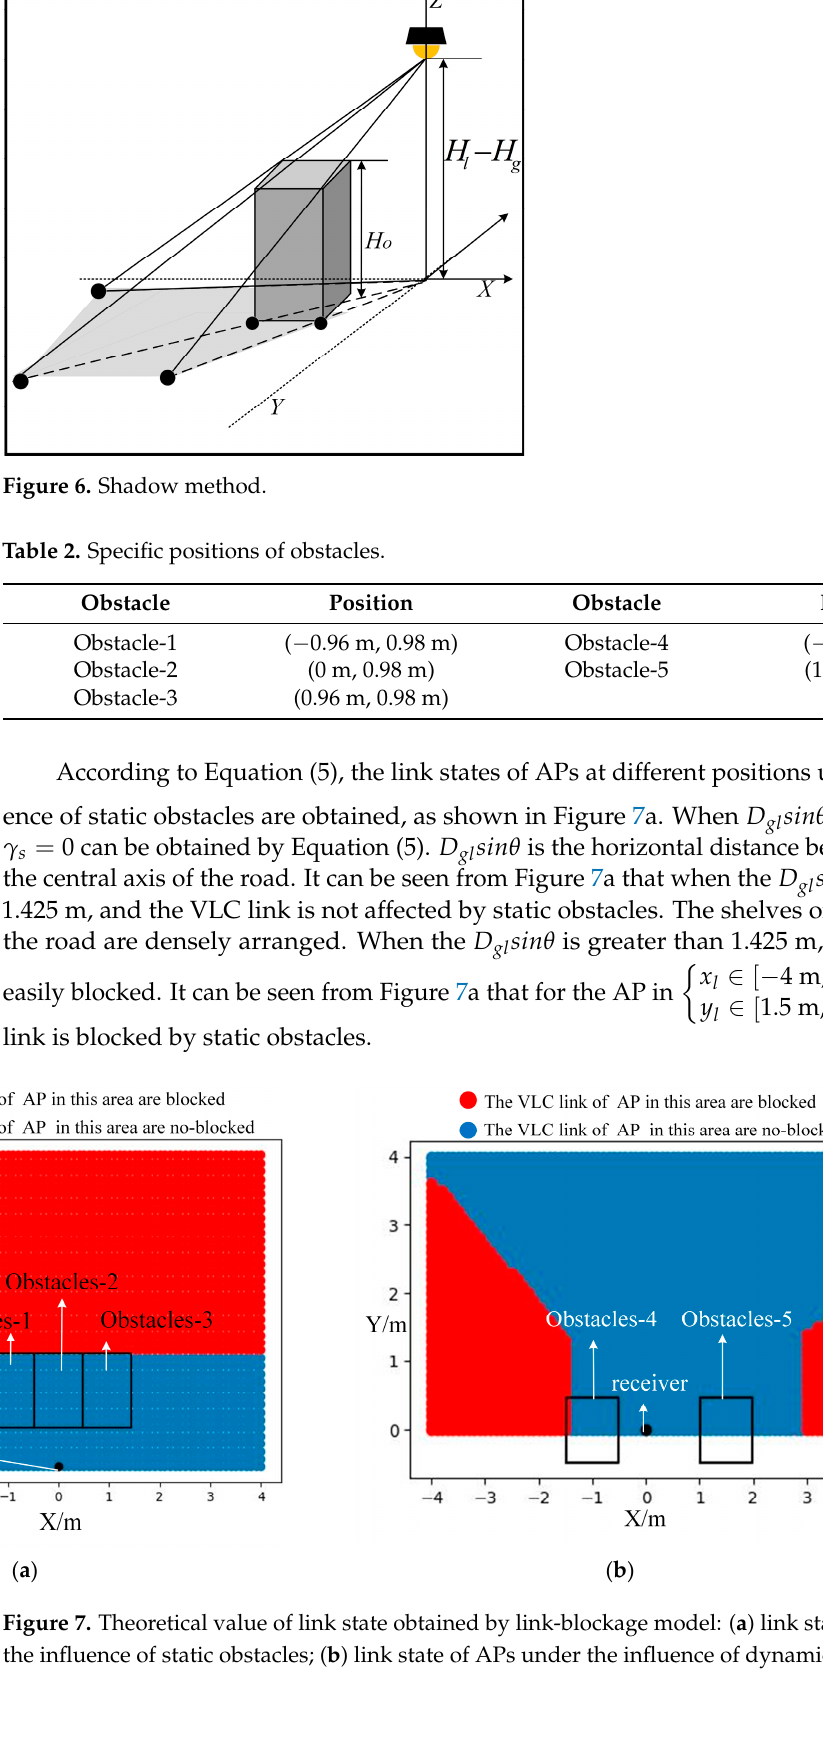
( b ) Figure 5. Influence of AP Spacing on VLC link: ( a ) 𝐷 (cid:3002)(cid:3017) < 2𝐷 (cid:3046)(cid:3028)(cid:3033)(cid:3032)(cid:3047)(cid:3035)(cid:3045) ; ( b ) 𝐷 (cid:3002)(cid:3017) ≥ 2𝐷 (cid:3046)(cid:3028)(cid:3033)(cid:3032)(cid:3047)(cid:3035)(cid:3045) . 5. Simulation and Data Analysis 5.1. Model Validity